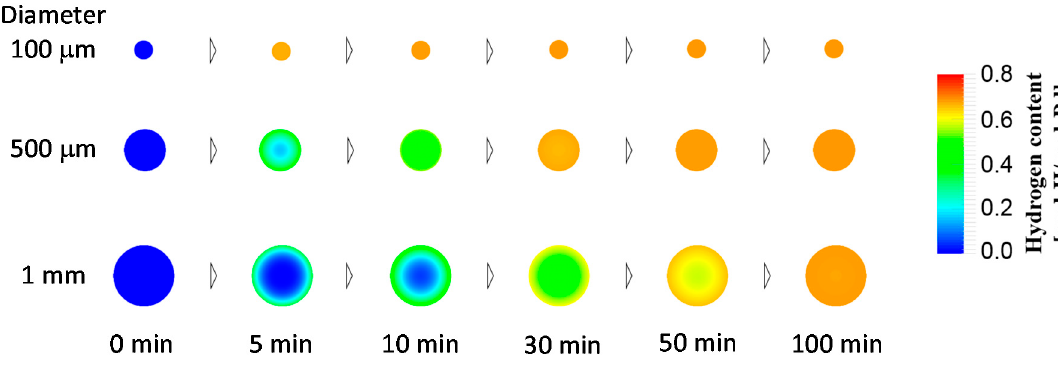
Figure 7. Simulated time evolution of hydrogen content in spherical Pd particles of various diameters.